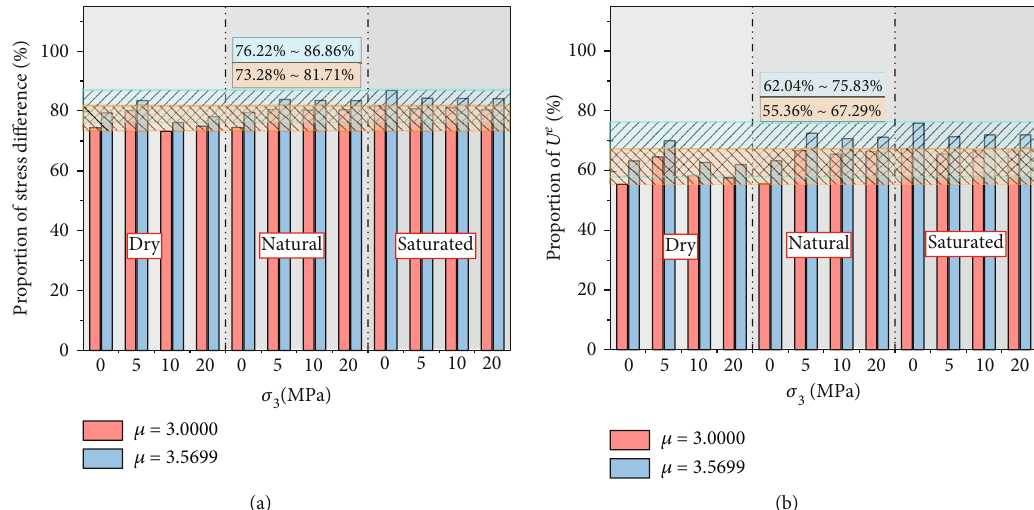
Figure 14: Proportion of deviator stress and elastic strain energy corresponding to di ff erent μ values: (a) proportion of deviator stress; (b) proportion of elastic strain